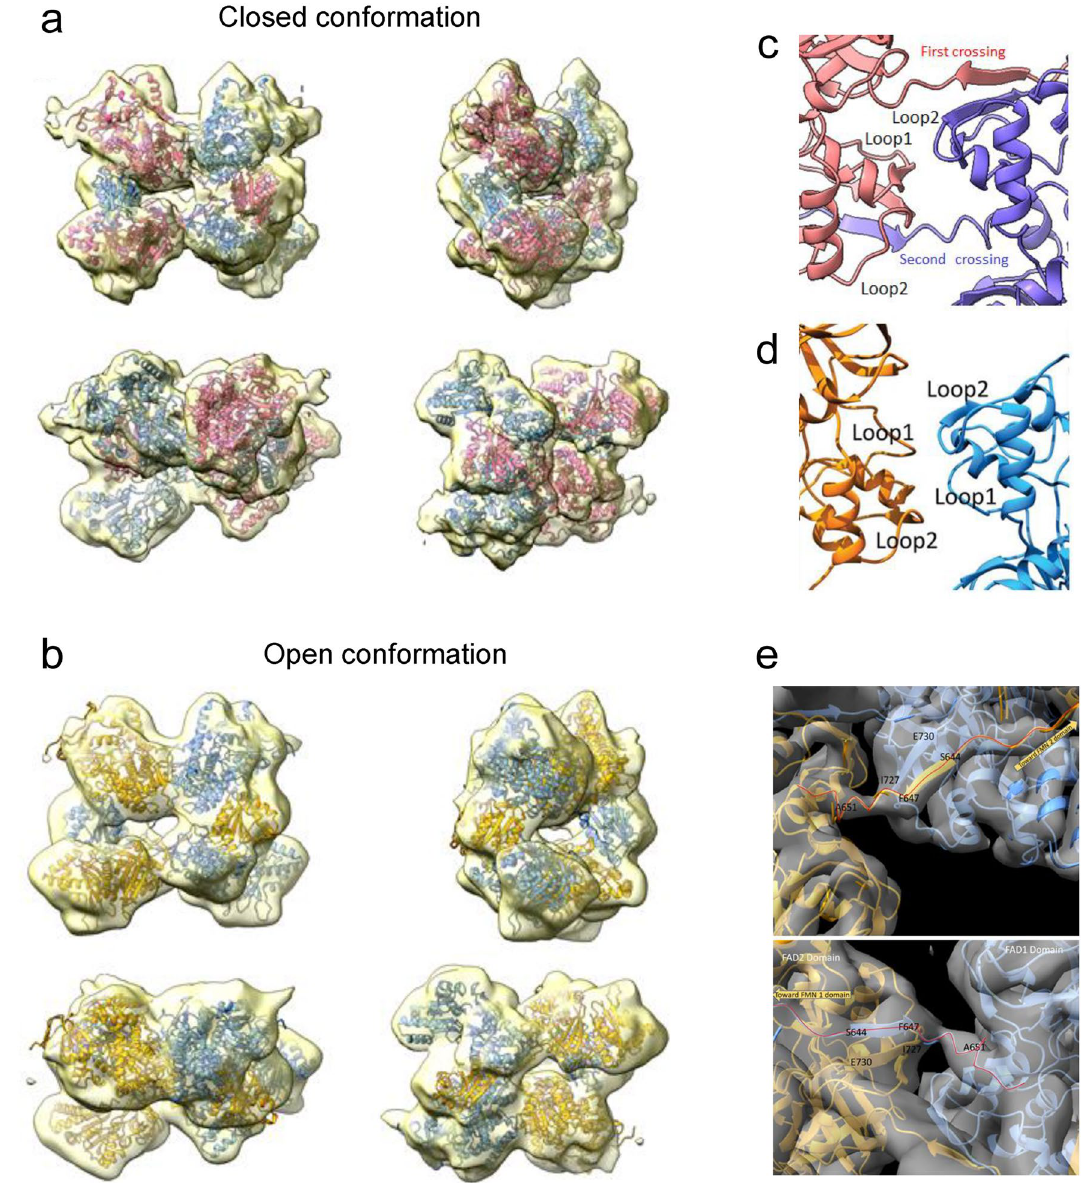
Figure 5. Comparisons of AF2A-predicted structures and experimental cryo-EM envelope of full-length CYP102A1 dimer. ( a–b ), The AF2A models ( trans P450d-FMNd geometry) for the Δ12 CYP102A1 variant in the closed (in a ) and open (in b ) conformations were embedded into cryo-EM EMD-20785 density map as described in “Methods” Section. The same color code was used for domains belonging to the same polypeptide chain. Experimental cryo-EM map is colored light yellow. Similar orientations were selected to help visualize the open and closed structures in the four presented orientations. ( c–d ), Comparison of the FADd-FADd interface in AF2A (top) and reported cryo-EM (bottom) models. Loop1 and loop2 correspond to the 8-residue long (residues 647 to 655) chain that crosses the FADd-FADd interface in the dimer. This loop exhibits an extended configuration in the dimer and crosses the interface (in c ), while it turns back to the FADd of the same monomer in the reported cryo-EM model (in d ). ( e ), Closer views of the FADd-FADd interface using the high resolution EMD-21100 density map (grey color) as a reference and the AF2A-modeled chains for the FMNd- FADd part in the closed conformation. The two AF2A-predicted chains in the dimer are colored differently for the sake of clarity. The thin red line in ( e ) highlights the course of the two crossing